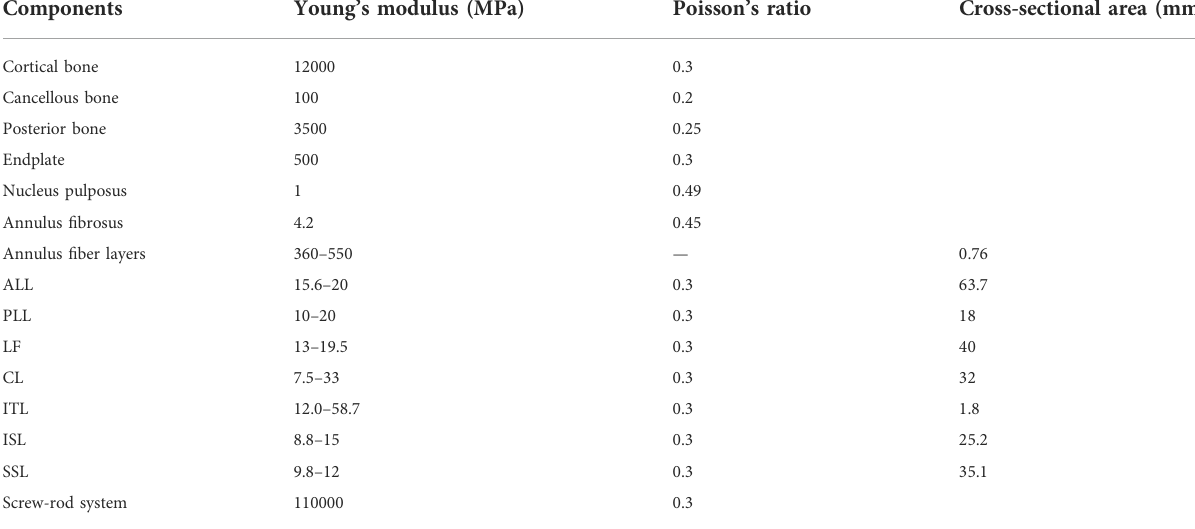
TABLE 1 Properties of different components in the lumbar spine model (Zhang et al.,